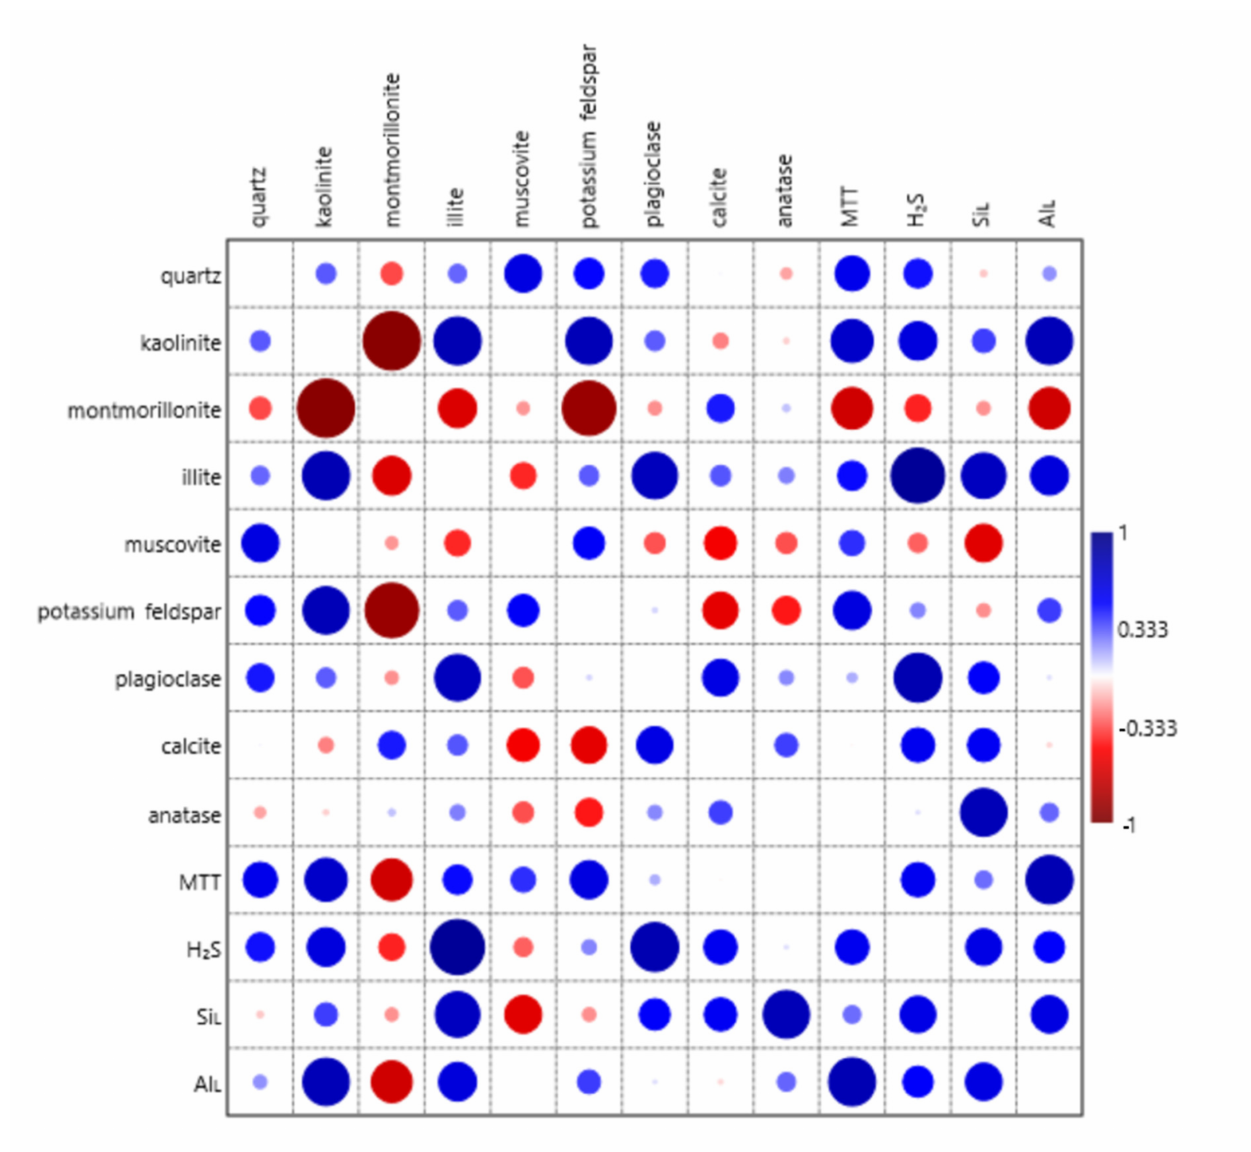
Figure 3. Relations between mineral composition and the processes in